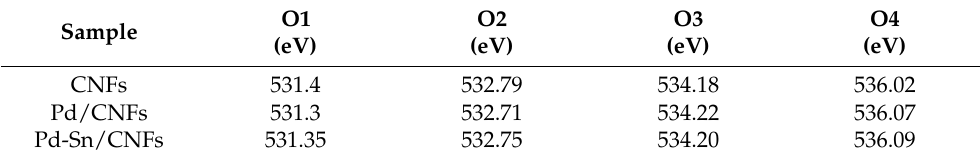
Table 3. The four components of the O 1s core level’s binding energies (eV).